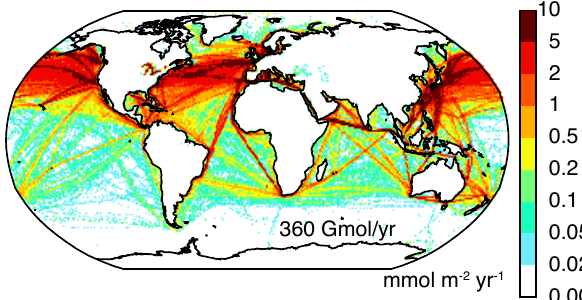
Figure 1. Annual ship NO x emissions (mmolm − 2 yr − 1 ) used in GEOS-Chem. The CTM includes monthly variations in locations and magnitude (not